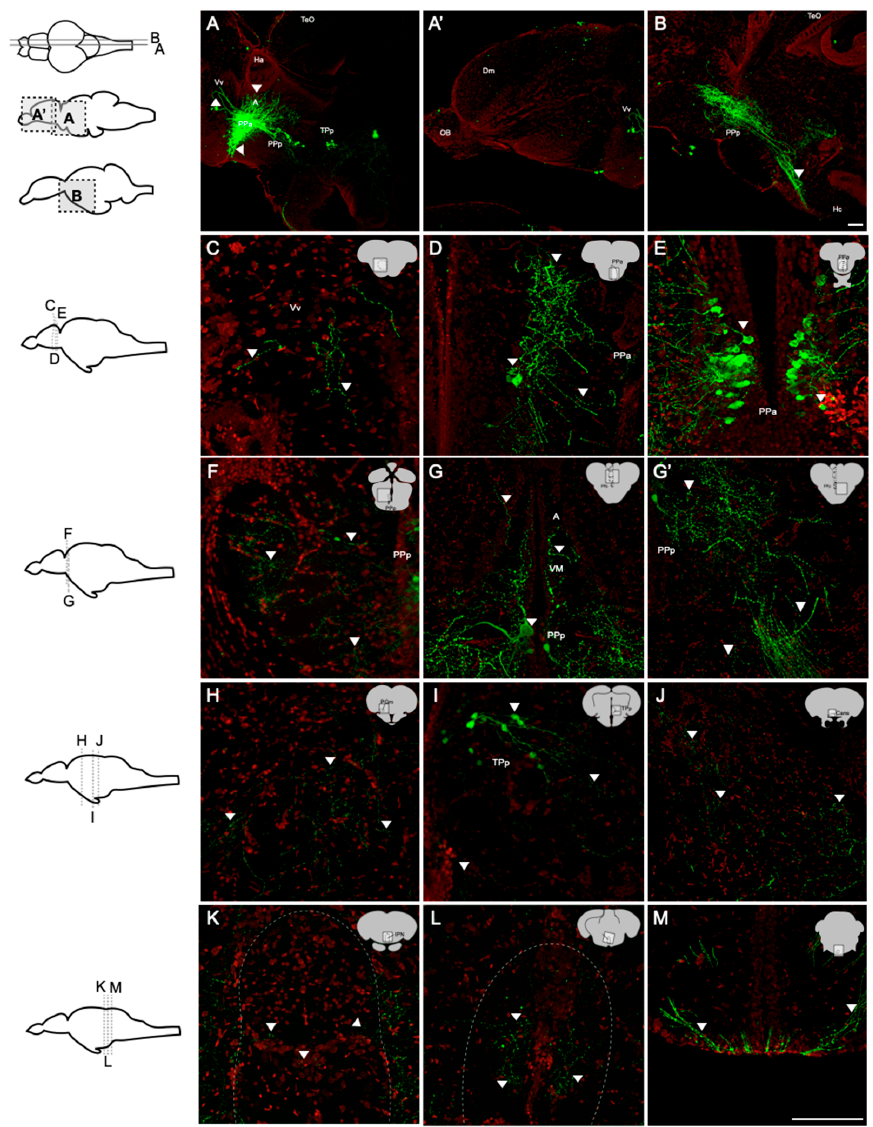
Figure 5. Distribution and projection of oxytocin neurons in the adult zebrafish brain ( n = 5). Whole-brain sections were stained with anti-GFP (green; oxytocin) and Nissl (red). ( A , B ) Sagittal sections showed that the fibers of oxytocin neurons were widely present in the brain. Somas were found in ( D , E ) PPa, ( F , G ) PPp, and ( I ) TPp. From the rostral end to the caudal end, the regions containing the fibers were found in ( C ) Vv, ( D , E ) PPa, ( F ) PPp, ( G ) A, VM, ( H ) PGm, ( I ) TPp, ( J ) Cans, ( K ) IPN, ( L ) raphe, and ( M ) TTBc. Scale bar = 100 µm.